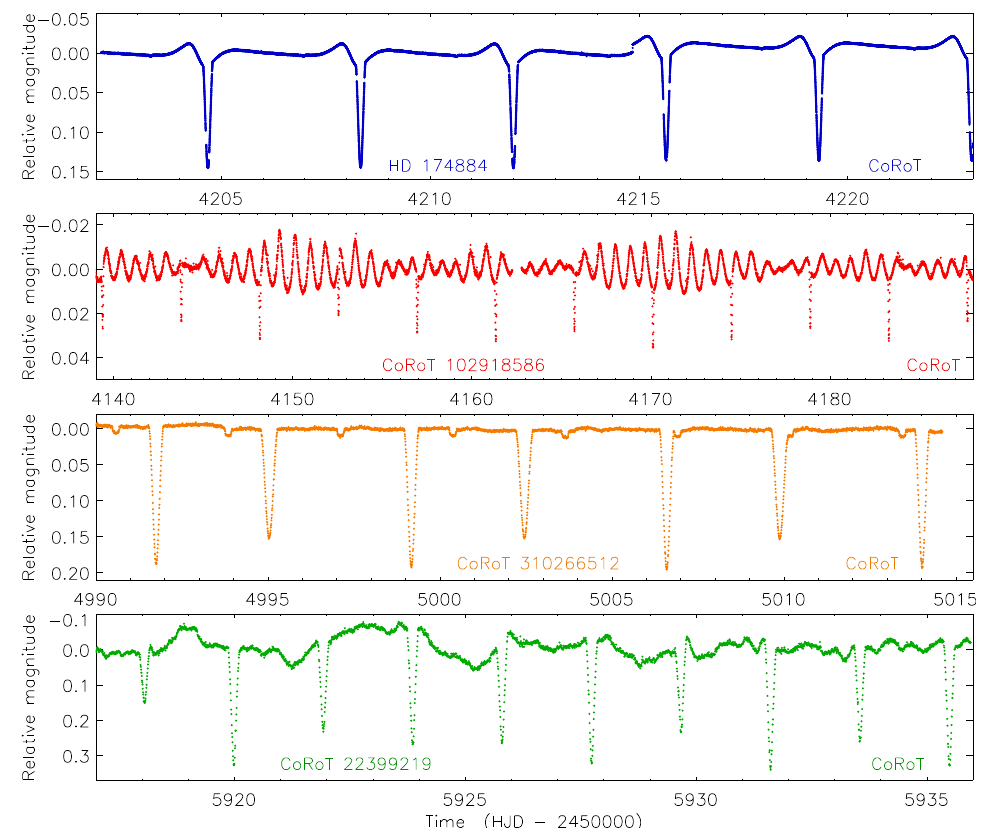
Figure 5. Parts of the CoRoT satellite light curves of four EBs